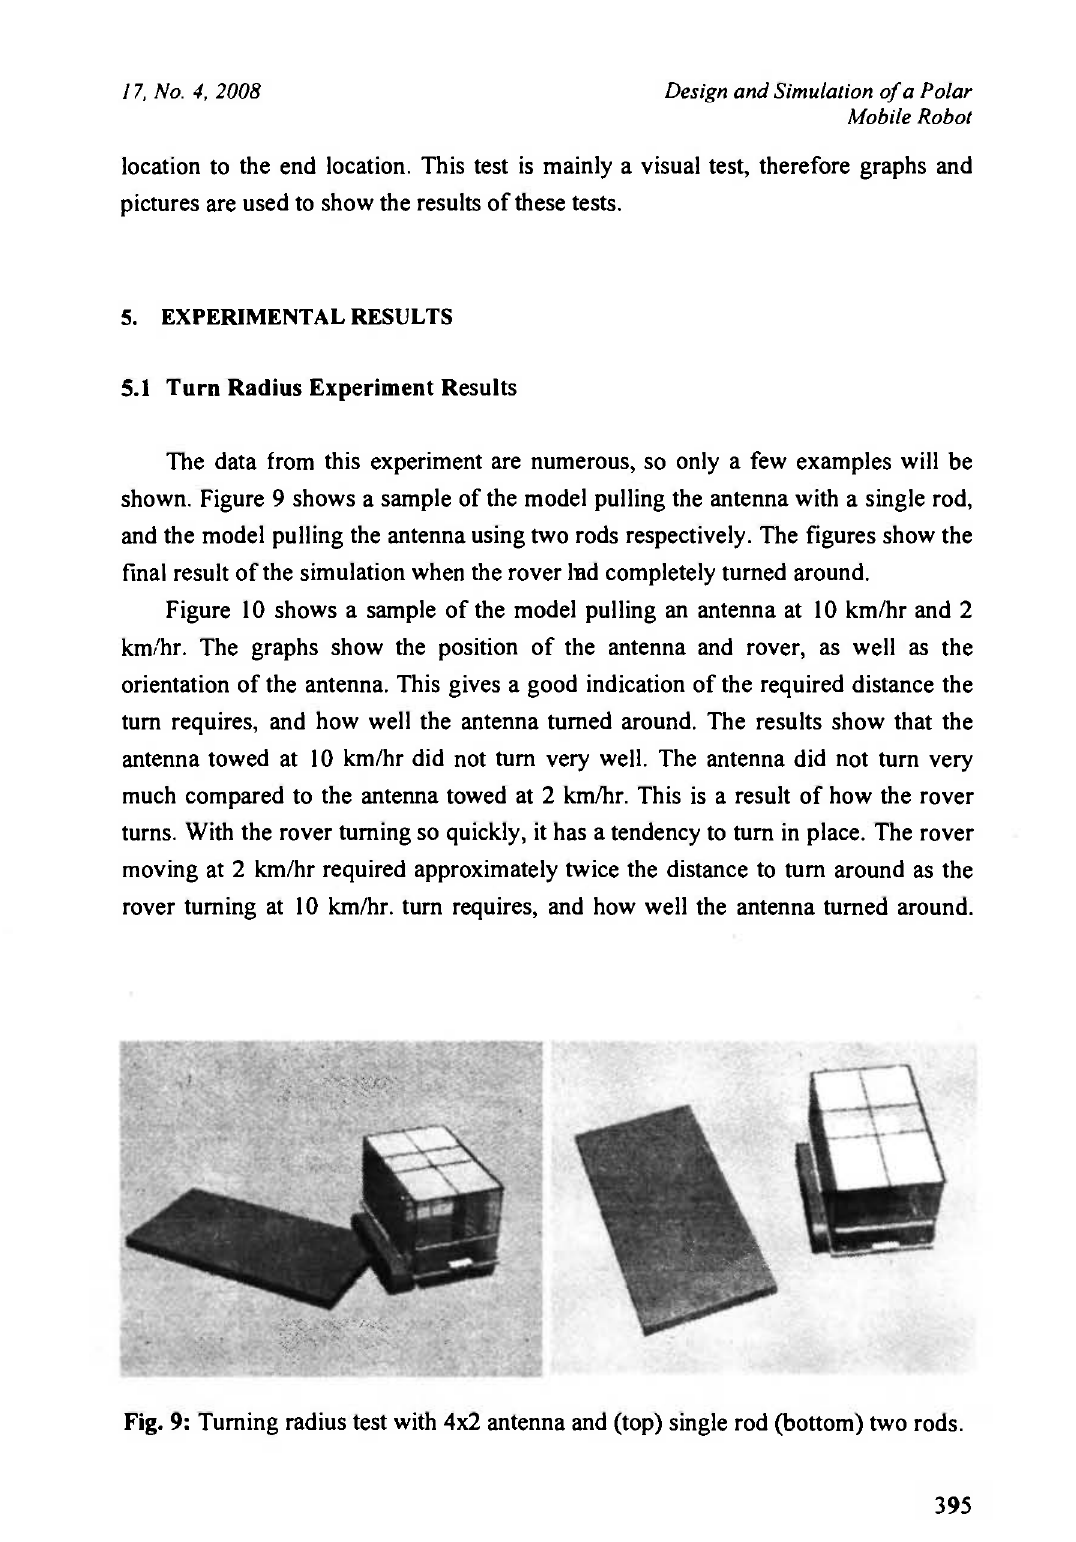
Fig. 9: Turning radius test with 4x2 antenna and (top) single rod (bottom) two rods.